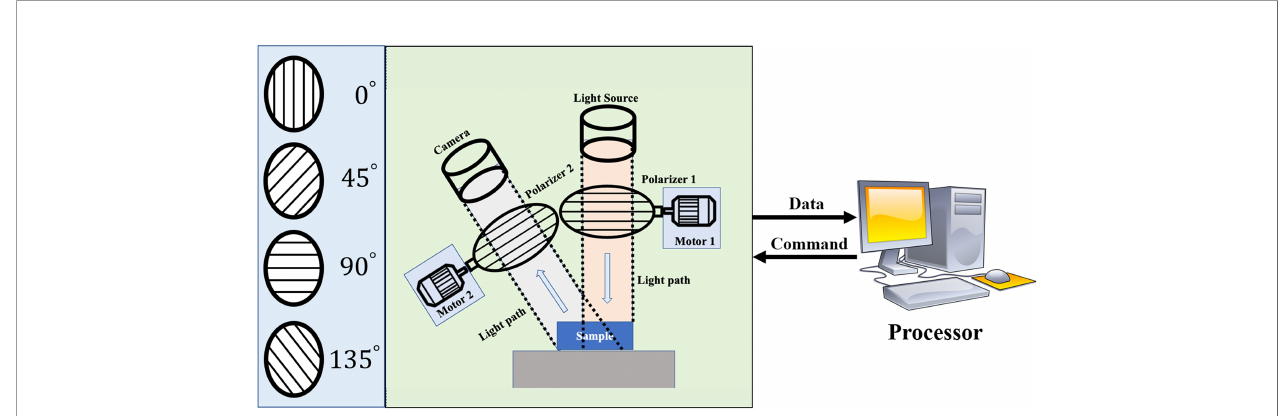
FIGURE 1 | The schematic diagram of the experimental